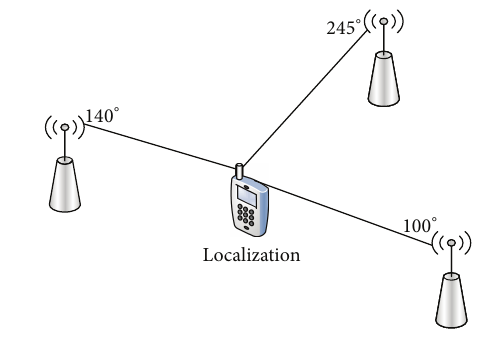
Figure 4: Angle-of-arrival positioning